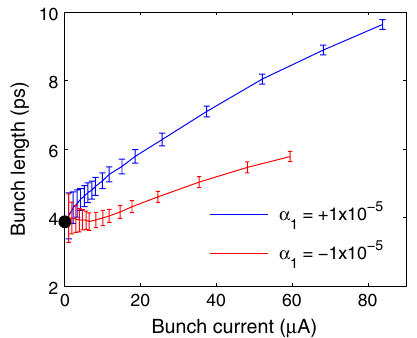
FIG. 6. Comparison between bunch length measurements made for the low-emittance lattice at j (cid:3) 1 j ¼ 1 (cid:5) 10 (cid:1) 5 . The cavity voltage was set to 1.5 MV. The theoretical natural (zero-current) bunch length given by Eq. (13) is also given.